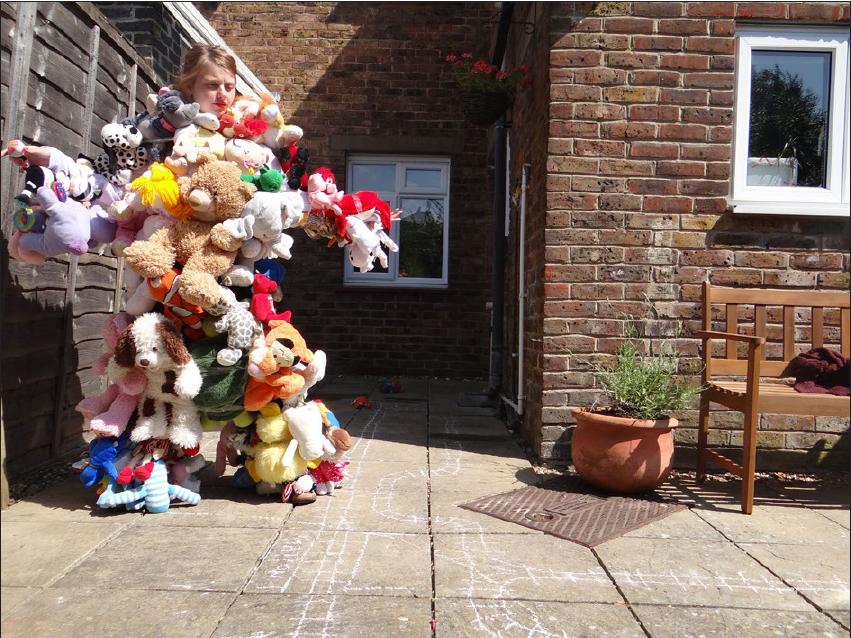
Figure 13: Jodie Hawkes, Motherstuff , digital